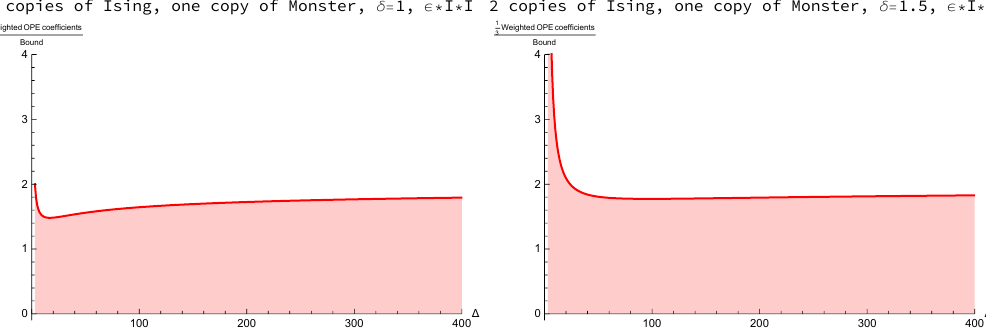
Figure 4 . Ratio of the weighted three point coe(cid:14)cients and the bound for 2 copies of Ising model tensored with one copy of Monster such that c e(cid:11) = 13. The plot being greater than one verifyies the lower bound. Here we have divided the weighted three point coe(cid:14)cients by the bin width 2 (cid:14) and we have taken the order one number appearing in the bound to be 0 : 5. Technically 0 : 5 can only be chosen for (cid:14) > 1 ’ 1 : 06, for low values of (cid:14) , the order one number is less than 0 : 5. (cid:13)